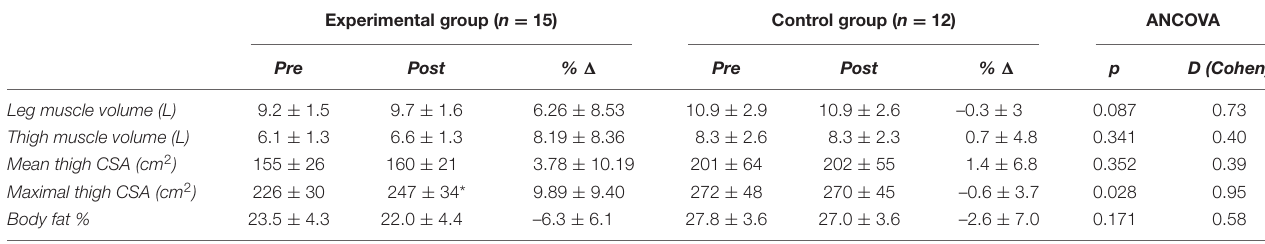
TABLE 5 | Comparison of lower-limb muscle volumes and cross-sectional areas between experimental and control groups before (pre) and after (post) the 8-week trial. Experimental group ( n = 15) Control group ( n = 12) ANCOVA